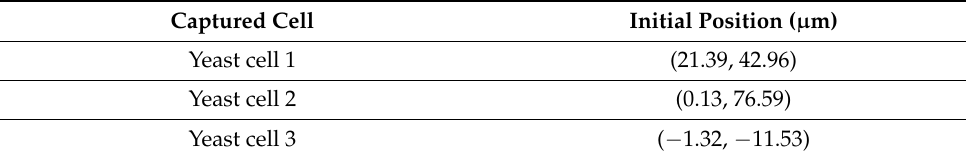
Table 5. Initial position of the captured